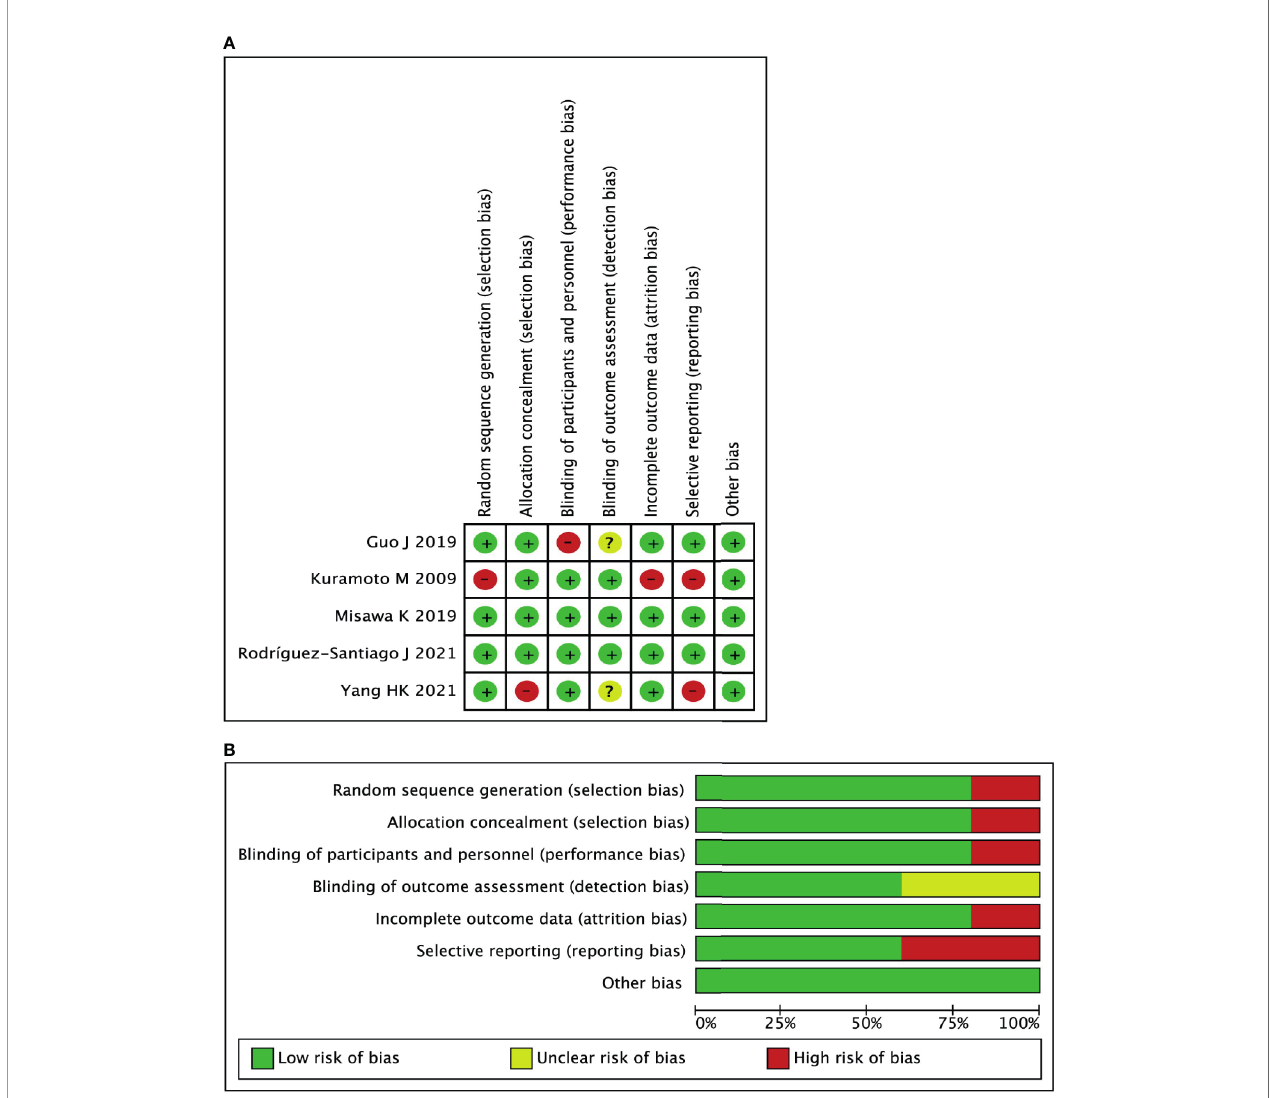
FIGURE 2 | Risk of bias for each included study. (A) risk of bias summary. (B) Risk of